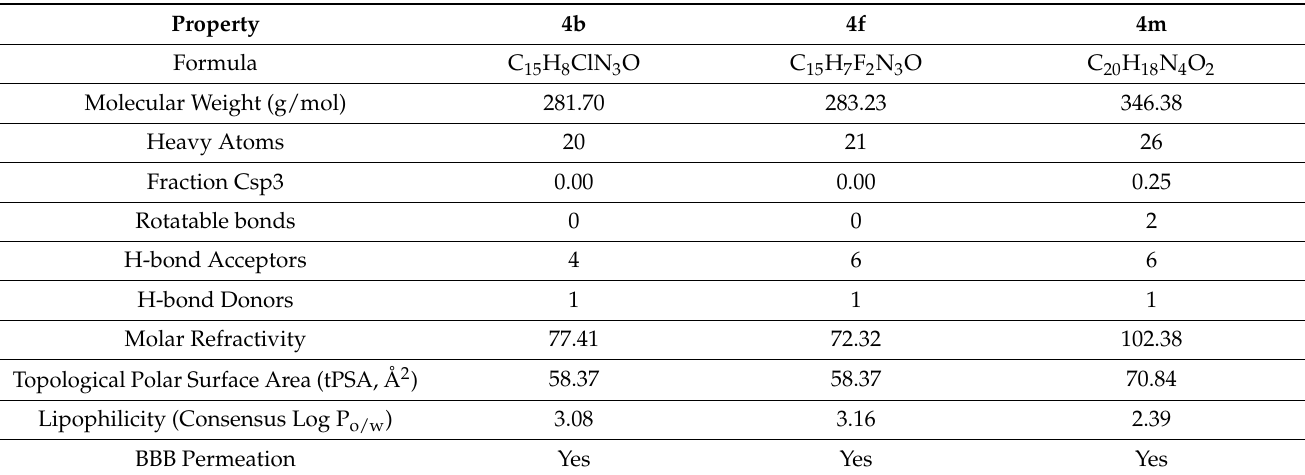
Table 5. Predicted ADME properties of compounds 4b , 4f , and 4m